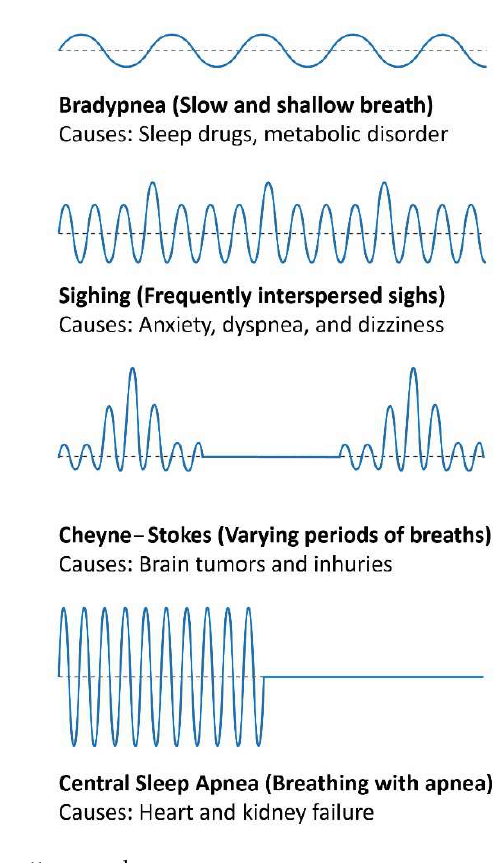
Figure 1. Breathing patterns and causes.